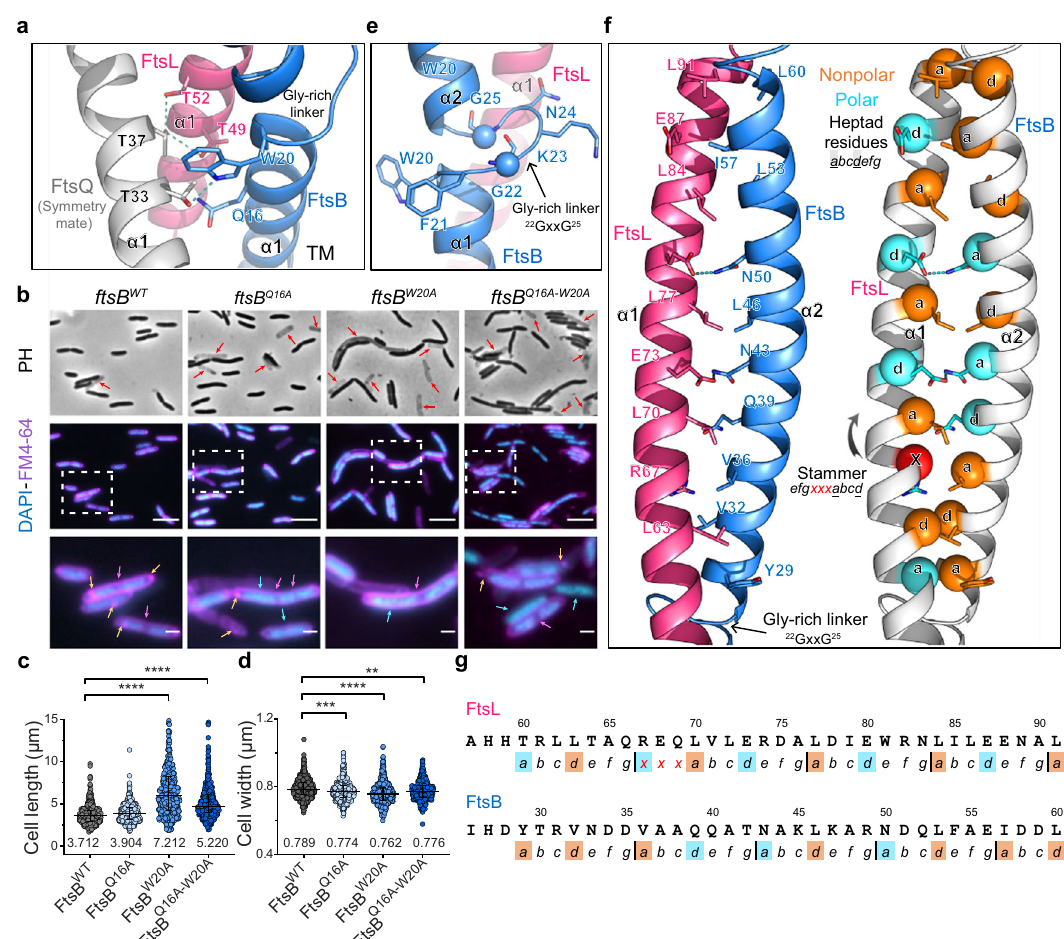
Fig.2|Structuralandfunctionalstudiesofthetransmembraneandthecoiled- coil domains of the FtsBLQ heterotrimer. a Potential interacting residues between FtsB (blue), FtsL (pink) with FtsQ (grey) from its symmetry mate at the transmembrane regions. Residues are shown in sticks and labeled in according colors. b Phenotypes of the ftsB -knock-down strain by CRISPRi and its com- plementationby ftsB WT , ftsB Q16A , ftsB W20A or ftsB Q16A-W20A mutants.PH:Phasecontrast; BlueDAPI:chromosomestain;PurpleFM4-64:membranestain.Arrowsindicatethe lysedcells(red),unsegregatedchromosome(cyan),lackofseptum(magenta),and membrane patches (orange). Scale bar, 5 μ m (middle column) and 1 μ m for enlarged views of the white box. c , d The cell length ( c ) and cell width ( d ) of the ftsB WT - ormutant-complemented cellsasin ( b ).The comparison was performed by